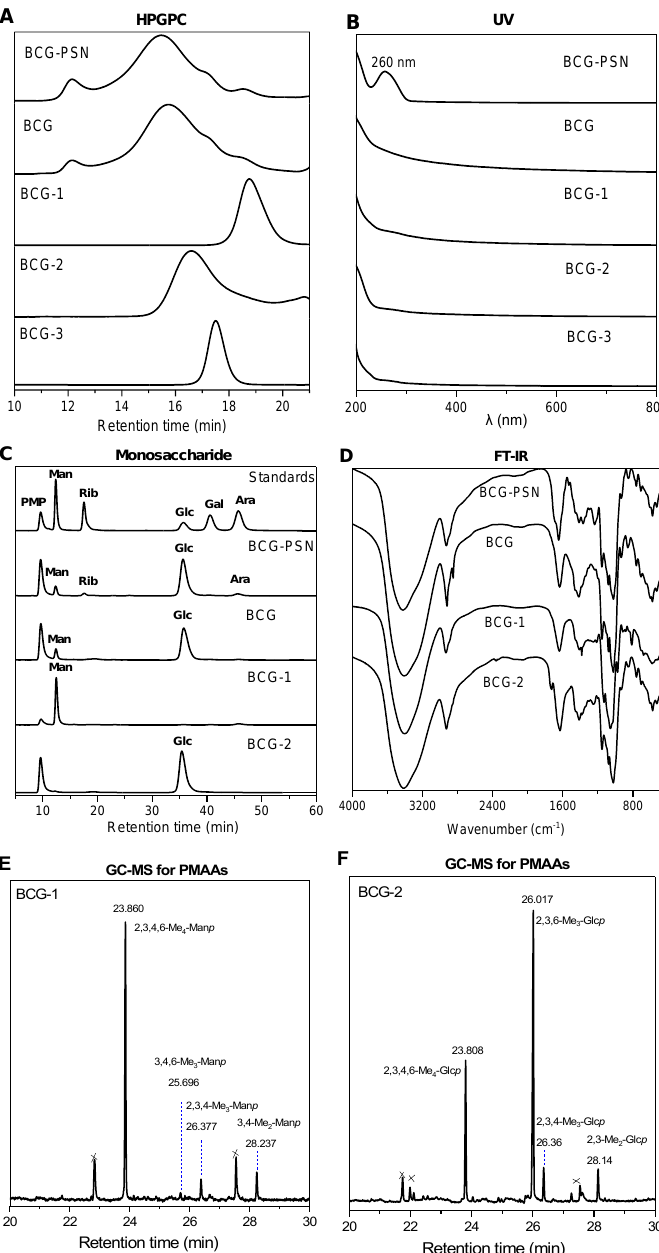
Figure 1. Purification and structural characterization of polysaccharides from BCG-PSN. ( A ) HPGPC profiles of BCG-PSN, BCG, BCG-1, BCG-2, and BCG-3; ( B ) UV absorption spectra of BCG-PSN, BCG, BCG-1, BCG-2, and BCG-3; ( C ) HPLC-DAD profiles of PMP derivatives of standard monosaccharides and the monosaccharides from polysaccharides; ( D ) FT-IR spectra of BCG-PSN, BCG, BCG-1, and BCG-2; ( E ) The TIC profile of PMAAs from the polysaccharide BCG-1; ( F ) The TIC profile of PMAAs from the polysaccharide BCG-2; noncarbohydrate signals are marked with ×.